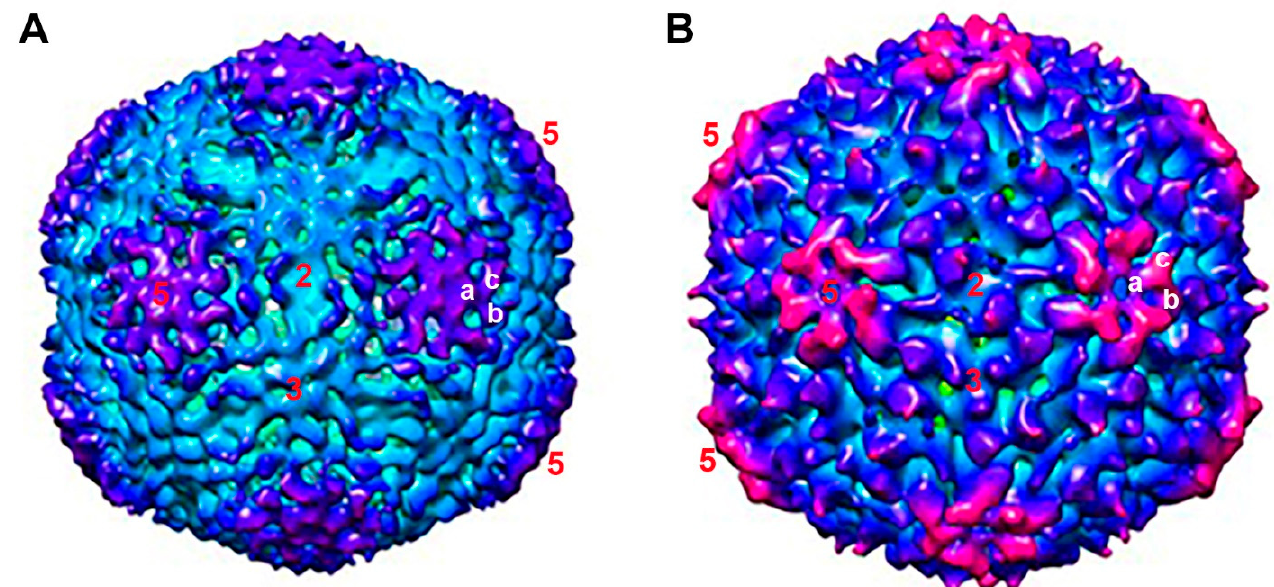
Figure 4. Comparative iso-surface maps of the empty VLP ( A ) and dsDNA-filled VLP ( B ). The color codes in the maps represent vertical distance from the center towards the periphery: yellow, 0–100 Å; green, 100–150 Å; cyan, 150–200 Å; deep blue, 200–250 Å; and pink, 250–300 Å. Numeric labels on the VLP represent two-, three-, and five-fold axes on the surface of IHHNV-VLP. Letters a-c are tripod feature around each five-fold axis.